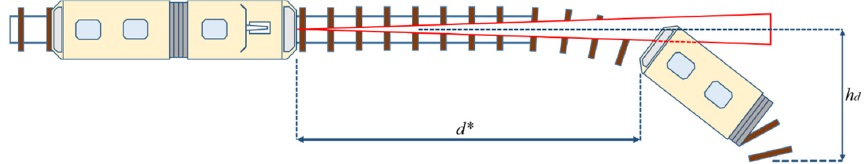
Figure 4. Horizontal misalignment LiDAR measurement.